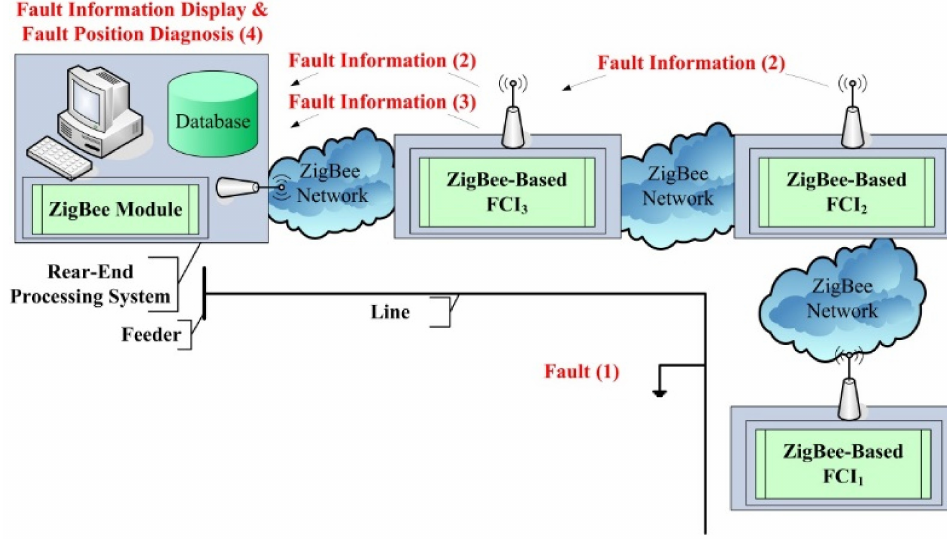
Figure 3. Basic concept of a Fault Management System